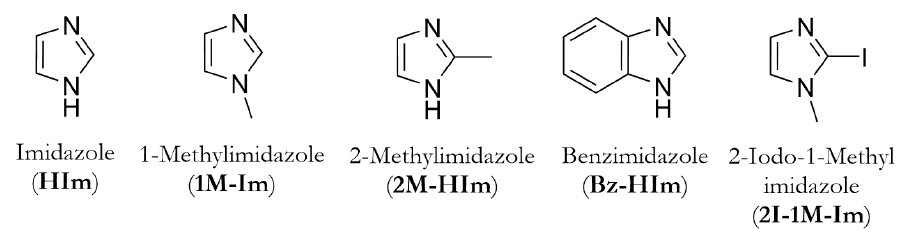
Figure 1. Imidazole and four of its derivatives.